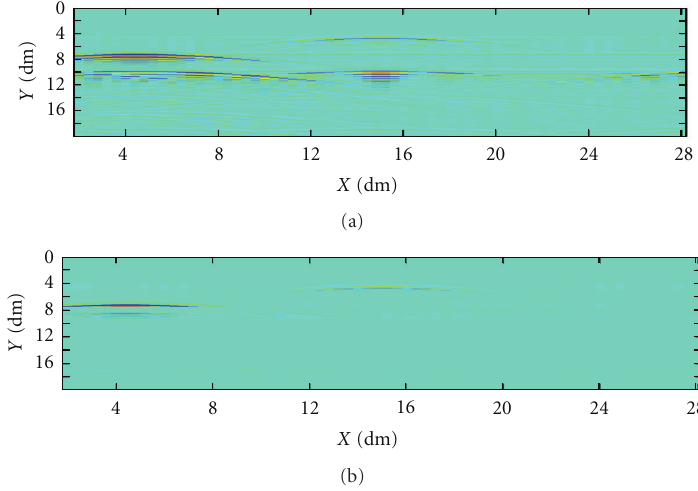
Figure 8: The case of Figure 7. (a) Radargramm after average trace subtraction, (b) windowed radargramm.